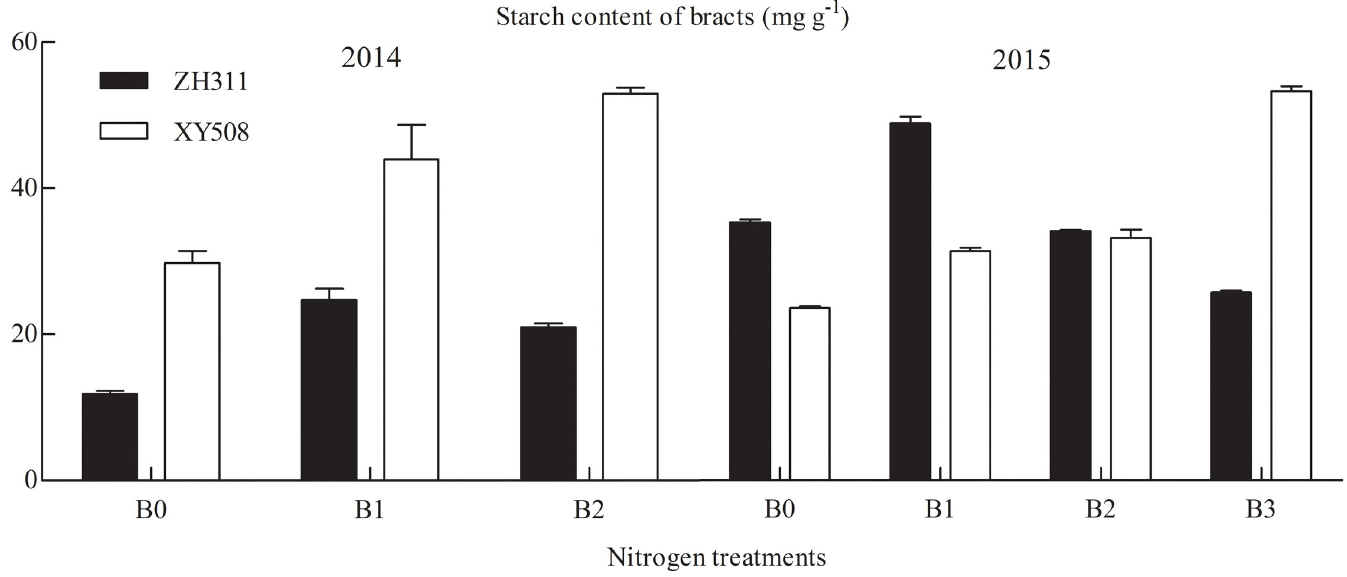
Fig 6. Starch content in the bracts at maturity under different nitrogen treatments. Note: B0, 0 kg � ha -1 ; B1, 150 kg � ha -1 ; B2, 300 kg � ha -1 ; B3, 450 kg � ha -1 .